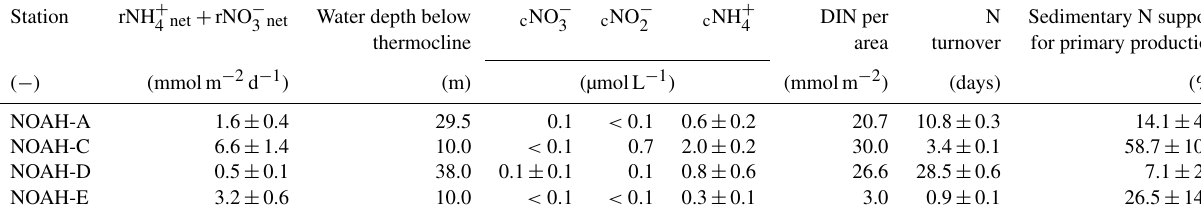
Table 3. Rates of benthic net NO − and benthic net NH + fluxes per area, water depth below thermocline (average value of all sediment 3 4 cores per station) and concentration of dissolved inorganic nitrogen (DIN) in the thermocline. Bottom water ( c NO − ammonium ( c NH + ). The concentration of DIN per area was calculated by the multiplication of the water depth below the thermocline with 4 the concentration of DIN. Turnover rates of nitrogen were calculated by the division of DIN per area by the rates of NH + and the effect of sedimentary N release on the reactive nitrogen available for primary production in the water